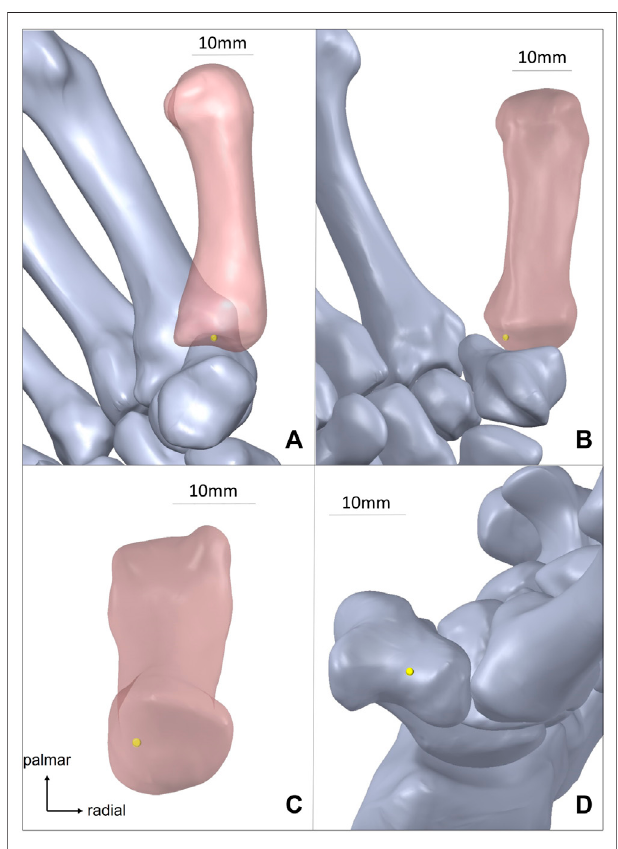
FIGURE3| Optimal centerofrotationin3Dbone models(yellow pointis the optimal center of rotation). (A) Optimal center of rotation of 1st metacarpal after arthroplasty from radial side. (B) . Optimal center of rotation of 1st metacarpal after arthroplasty from palmar side. (C) Model of 1st metacarpal bone from proximal side. (D) . Optimal center of rotation without 1st